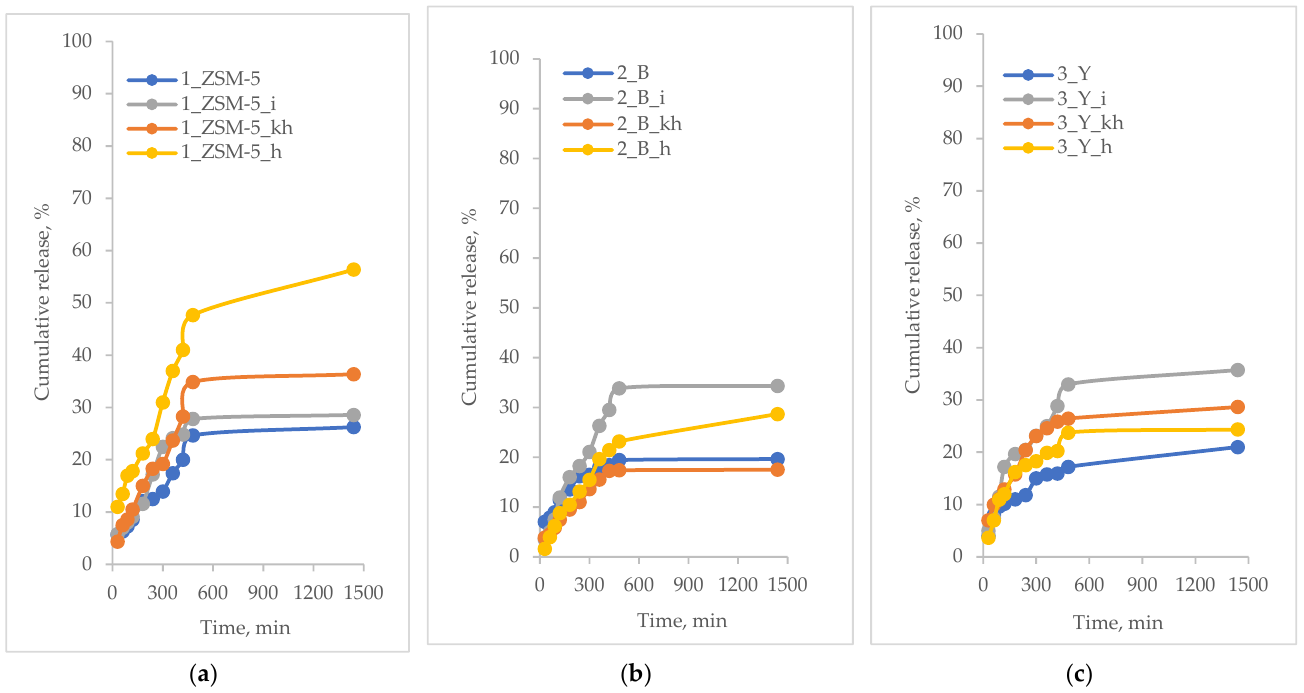
Figure 6. Percentage of ferulic acid released from modified hierarchical zeolites into acceptor fluid with glycerin; ( a ) samples based on ZSM-5 zeolite; ( b ) samples based on BEA zeolite; ( c ) samples based on FAU zeolite.